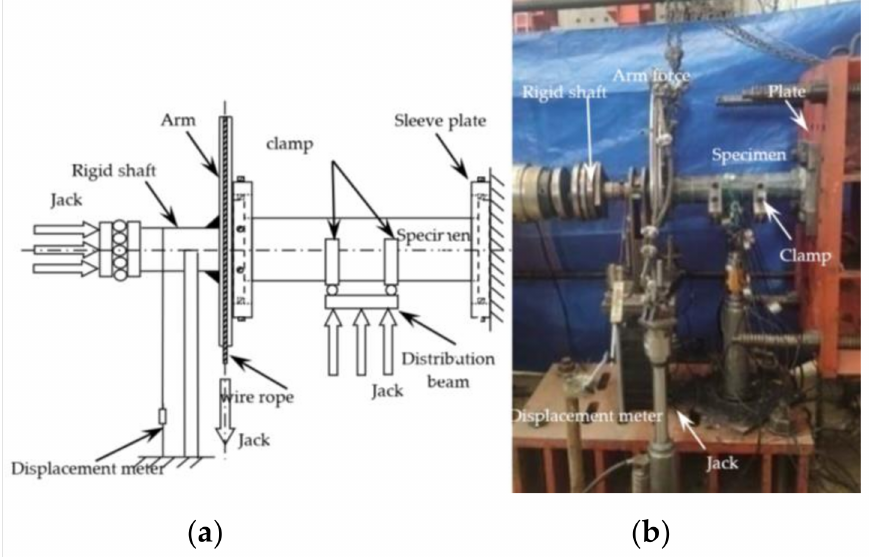
Figure 2. Diagrammatic sketch and physical figure of loading equipment. ( a ) Diagrammatic sketch of loading equipment. ( b ) Physical figure of loading